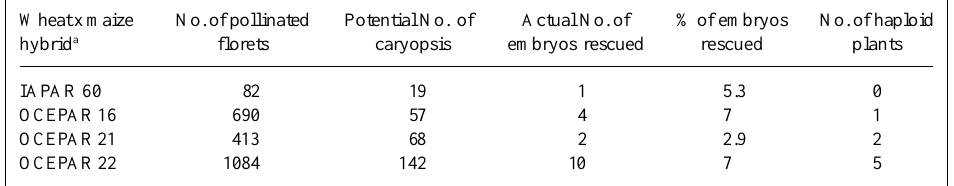
Table III - Number of embryos and haploid plants of some wheat cultivars regenerated through embryo rescue technique. Wheat x maize